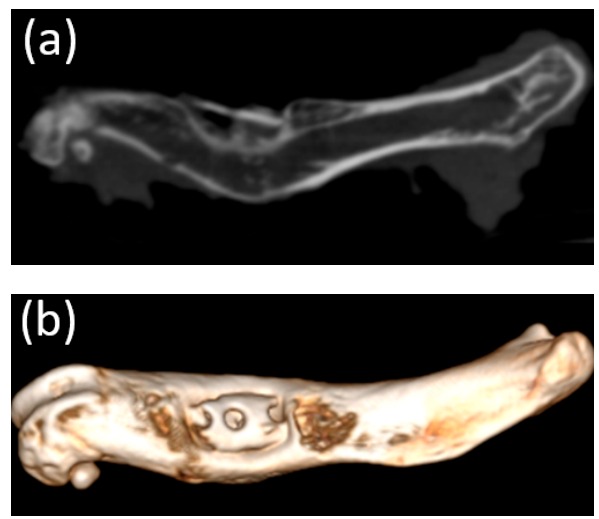
Figure 10. ( a,b ) Image of the femur of an animal 6 months after implantation (obtained with CBCT).